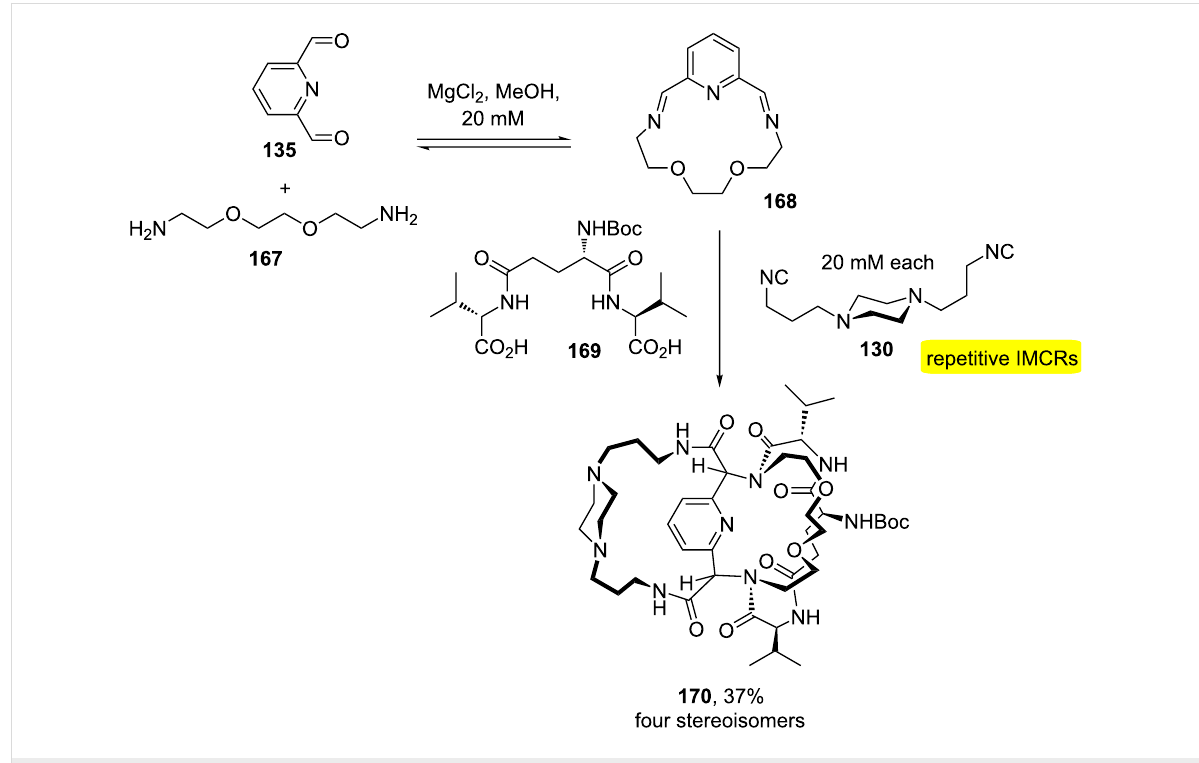
Scheme 33: Template-driven approach for the synthesis of macrotricycles 170 [50].